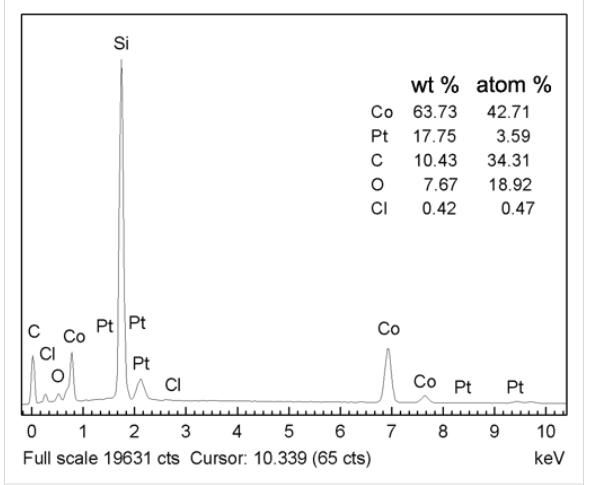
Figure 2: EDS spectrum of the PVP-protected cobalt nanowires pre- pared under an external magnetic field. Silicon was left out from the composition evaluation for the sake of